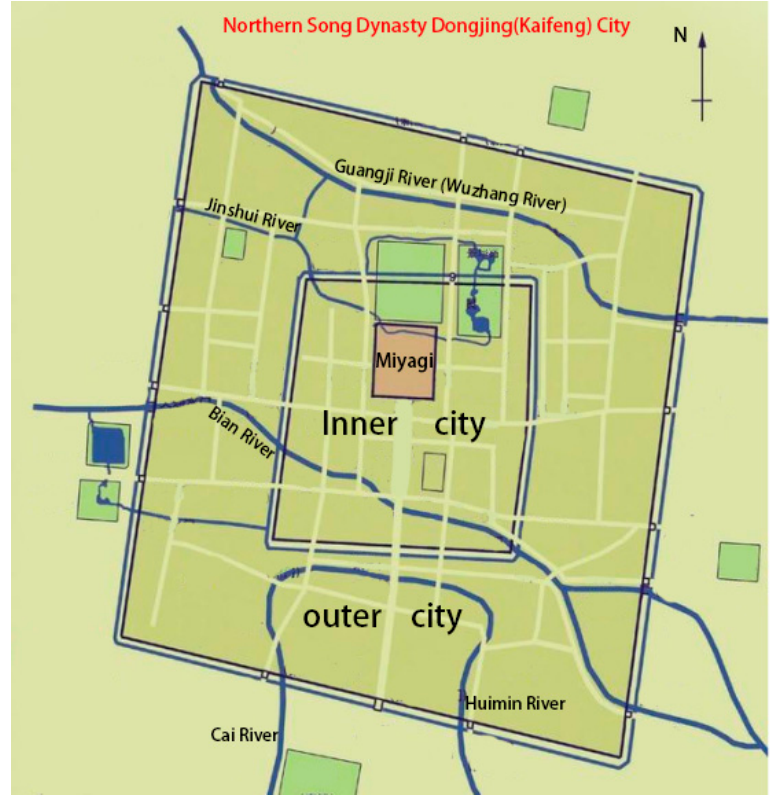
Figure 4. The vast size of Kaifeng in the Northern Song Dynasty and the four canals that passed through the city.